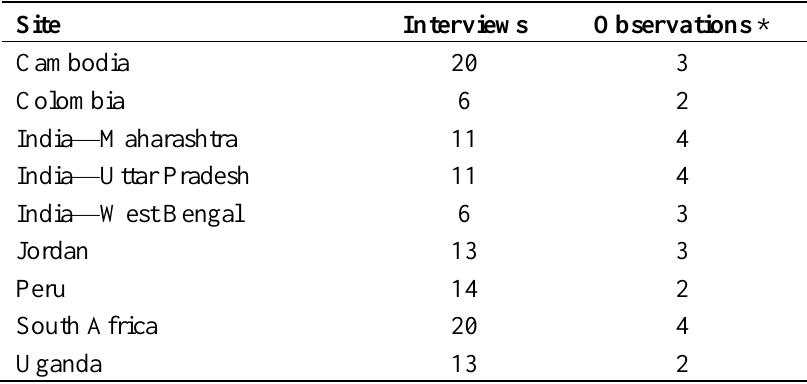
Table 1. Data collection activities.